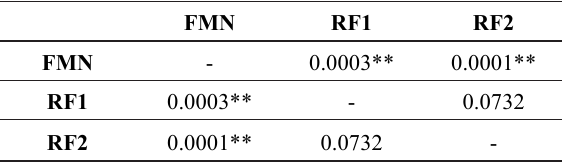
Table 2. Analysis of similarity (ANOSIM) among three sites of dif- ferent forest regeneration stages: a fragment of secondary forest (FF) one area of reforestation with five years (RF2) and other with seven years of reforestation (RF1).